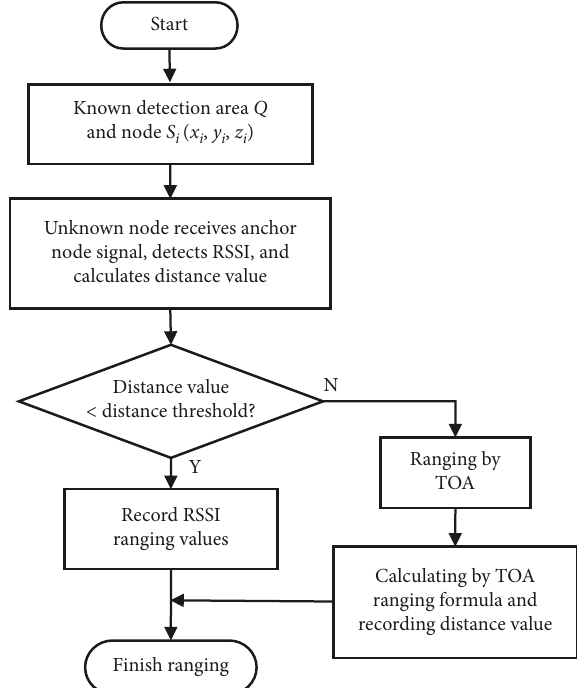
Figure 3: Ranging process with the RSSI and TOA